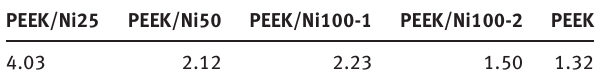
Table 2: Bulk density (g/cm 3 ) of PEEK/Ni